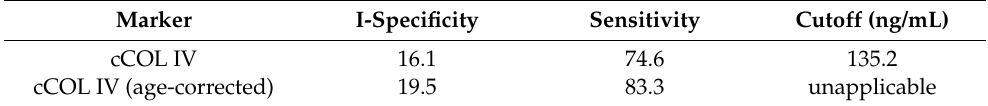
Figure 7. ROC curve analysis of circulating type IV collagen (cCOL IV) before (AUC 0.8791) and after adjusting for age (AUC 0.9027). Table 4. Specificity, sensitivity, and cutoff for cCOL IV.